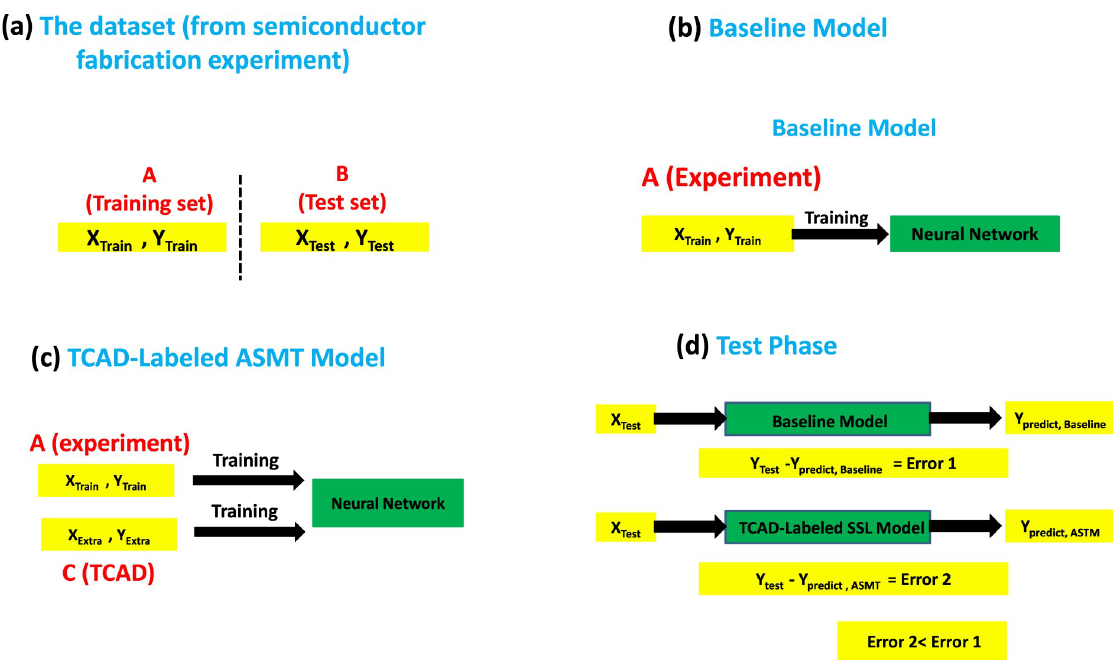
Fig 3. Implementation of TCAD-labeled ASMT. (a) The dataset is split into the training set and test set. (b) The baseline model is trained with the experimentally labeled data. (c) The TCAD-labeled ASMT model is trained with the experimentally labeled and TCAD-labeled data. (d) The test phase of the baseline and TCAD-labeled ASMT